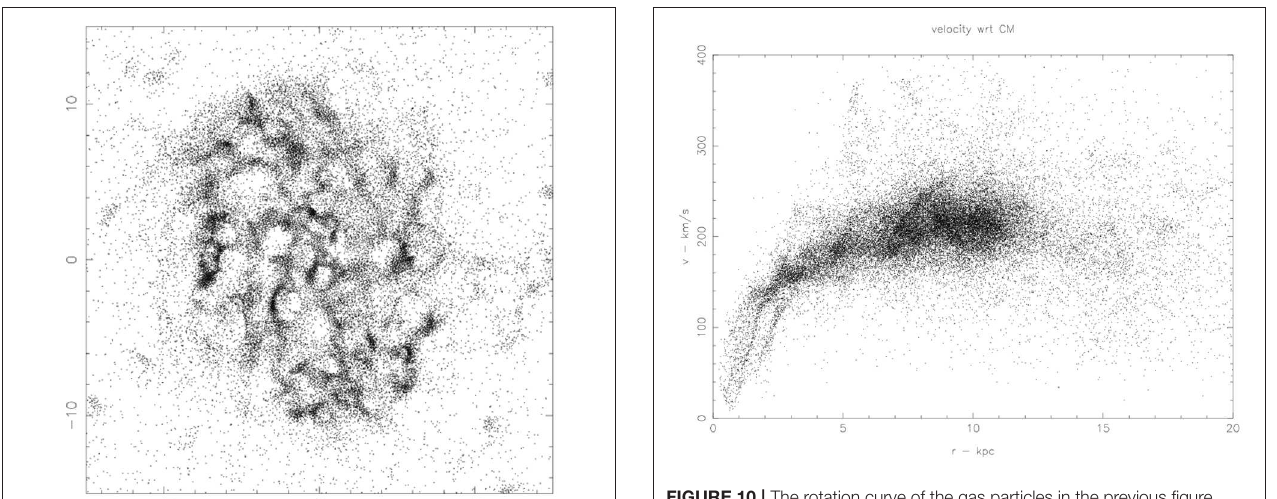
FIGURE 10 | The rotation curve of the gas particles in the previous figure.